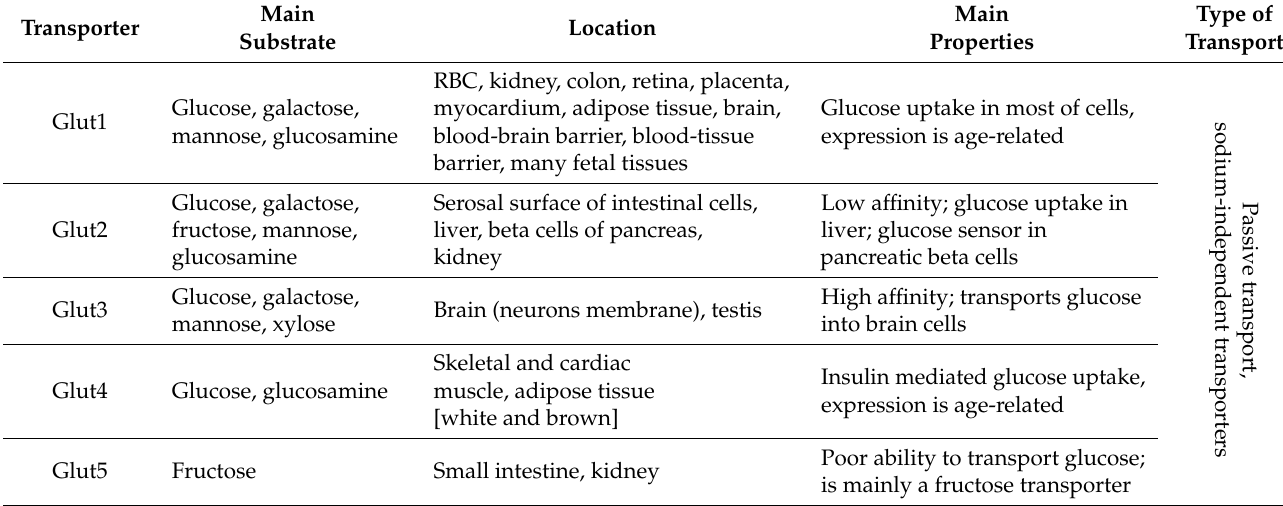
Table 1. Major types of known glucose transporters